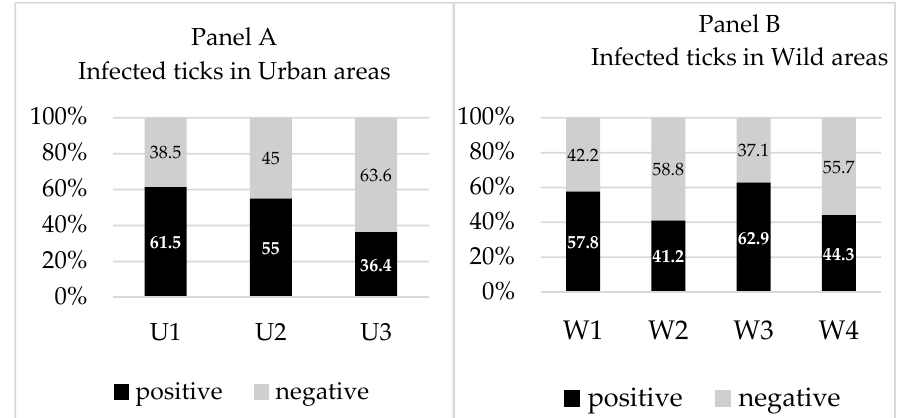
Figure 3. The rate of DMF and/or PCR positive ticks in which Borrelia sp. was detected regardless of the method of testing in urban (U1–U3) and wild (W1–W4) areas within Kaylaka Park. Data are presented as percentages.